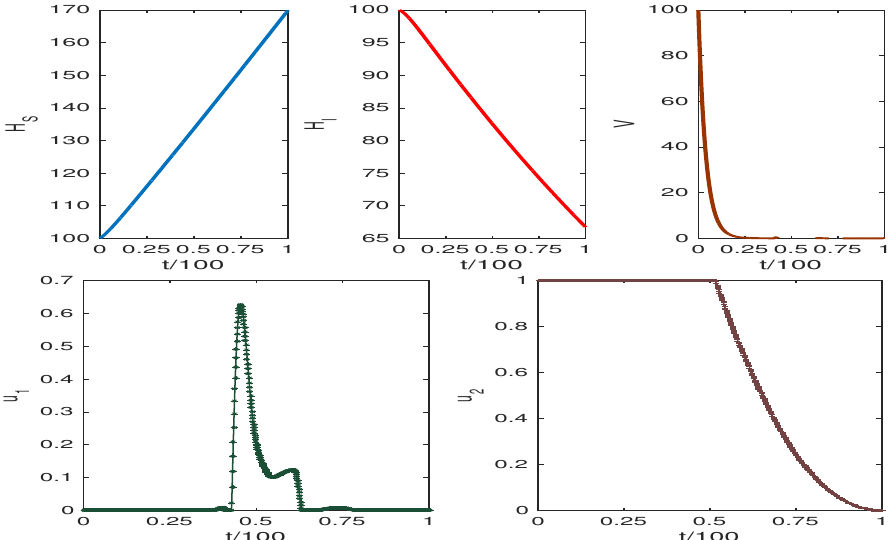
Figure 7. The graphs represent the effect of control and the variation of optimal control variable with the value of the fixed parameters taken from Table 1, and the weight constants are taken from Table